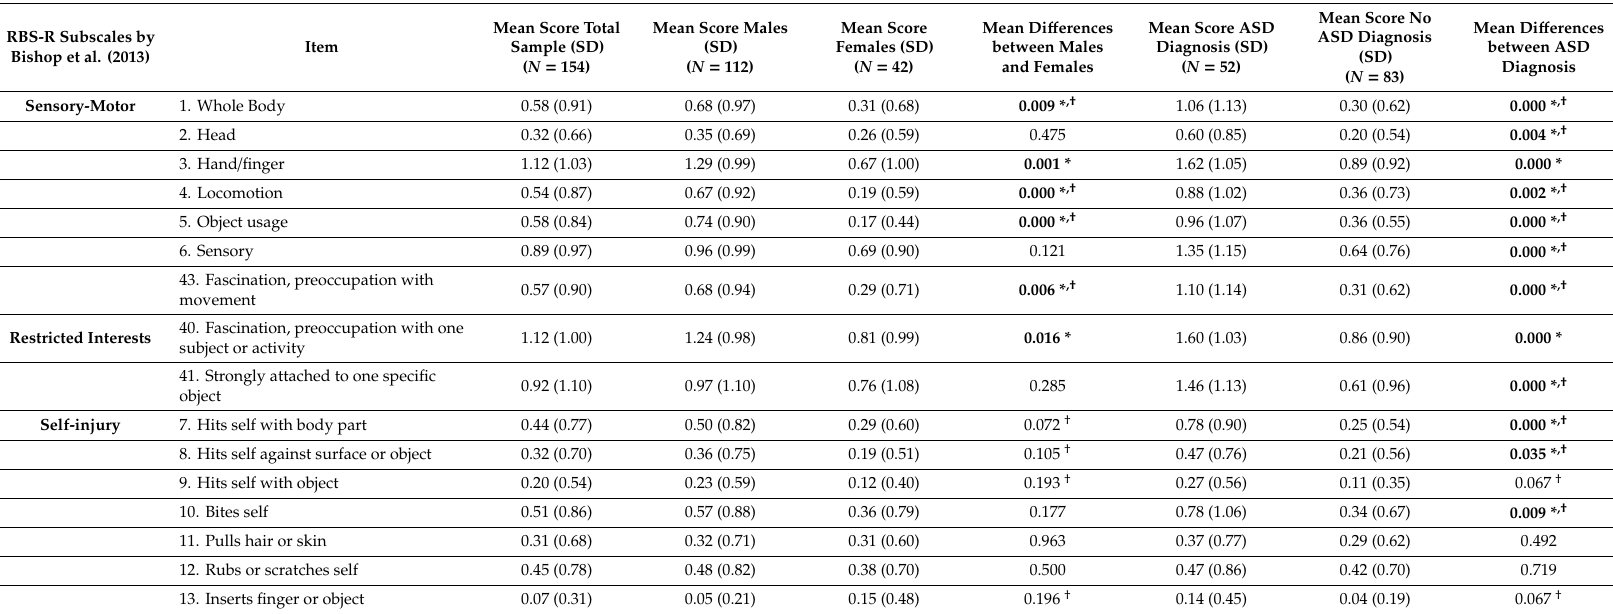
Table 3. Repetitive Behavior Scale-Revised (RBS-R) item means by overall sample, gender, and autism spectrum disorder (ASD) diagnostic status according to Bishop et al.’s (2013) 5-factor